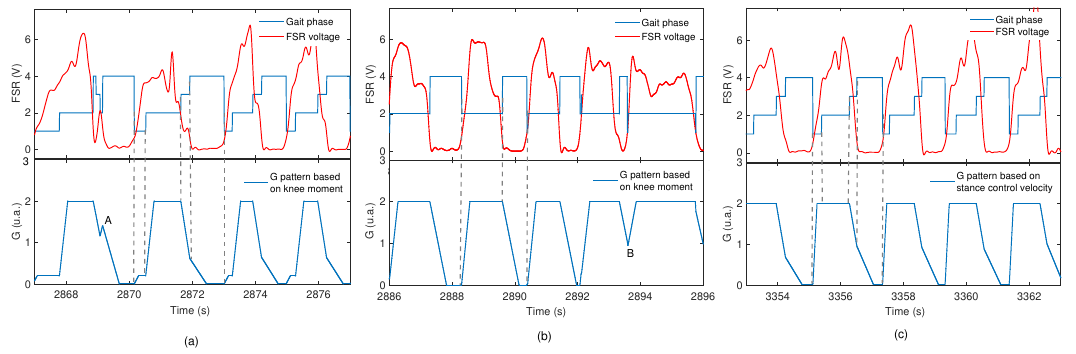
Figure 11. M variation during gait cycle. ( a ) variation of M during a gait test, which generates four sub-phases: initial contact (IC), mid-stance (MS), terminal stance (TS) and swing (SW); ( b ) example with three sub-phases; ( c ) example that shows the variation of M during a gait cycle with